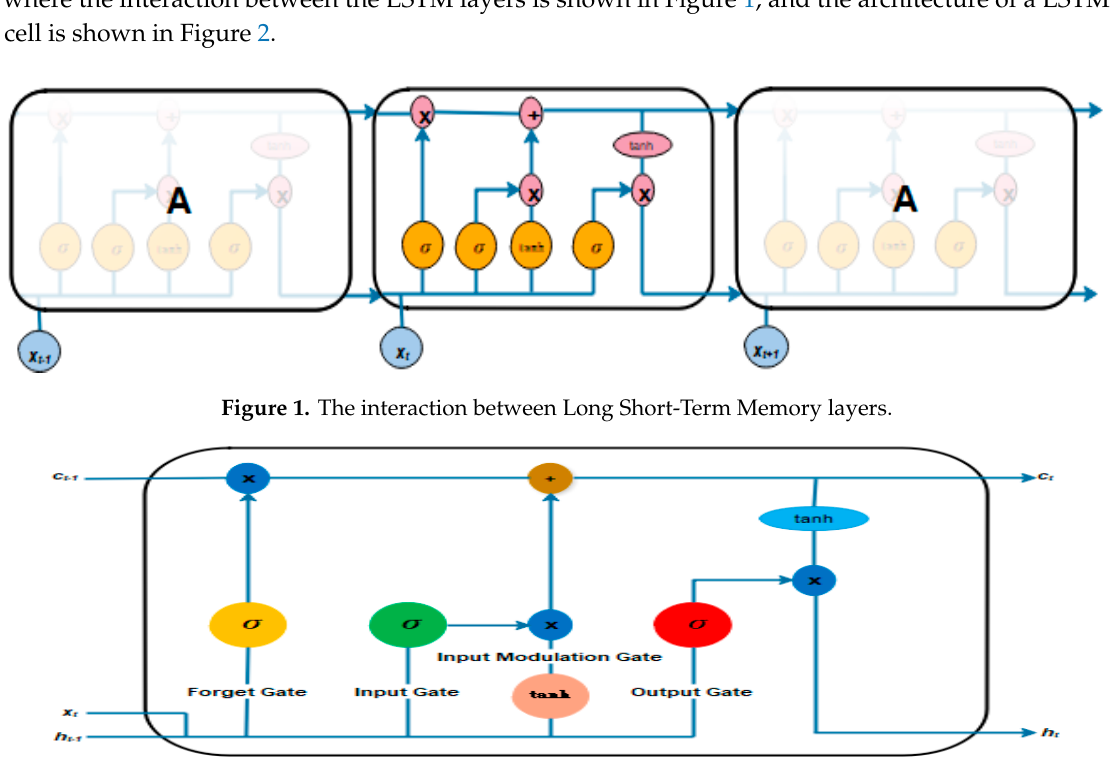
Figure 2. The architecture of the Long Short-Term Memory cell.